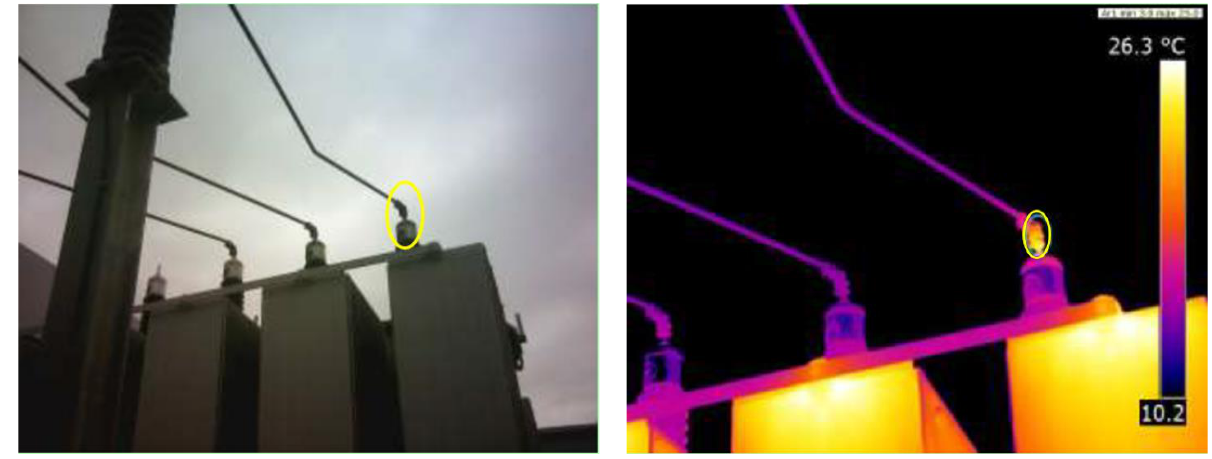
Figure 1. Visible and infrared images of a hot spot in a 66 kV transformer bushing connector.